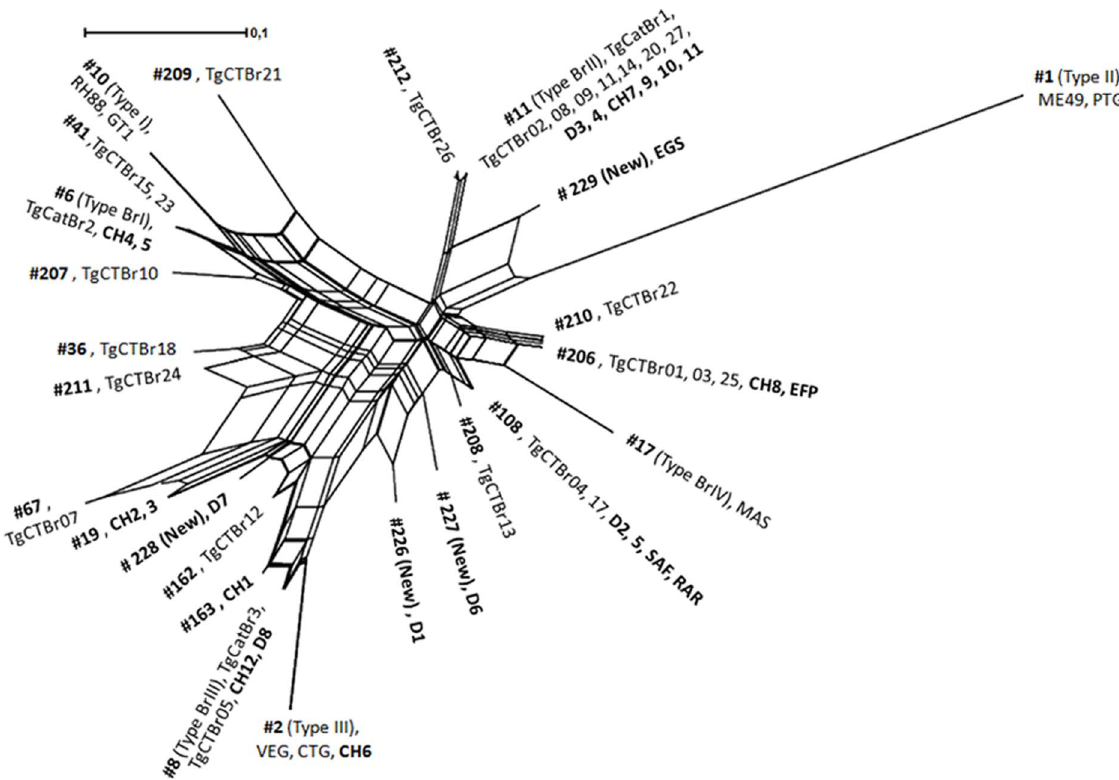
Figure 1. NeighborNet phylogenetic network of Toxoplasma gondii isolates from animal and humans in Minas Gerais. Isolates genotyped in this study are highlighted in bold. Isolates TgCTBr01 to TgCTBr26 were obtained from newborns in Minas Gerais and previously